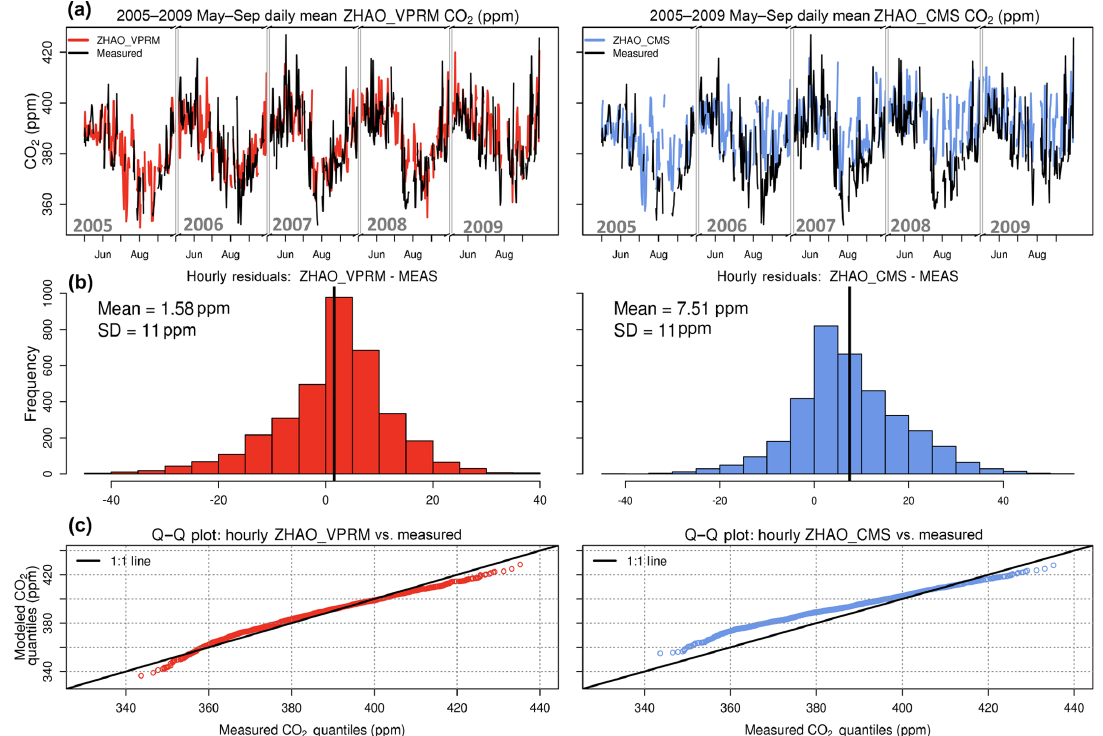
Figure 8. Comparison of modeled and measured CO 2 during May–September 2005–2009, using two different vegetation models. (a) Daily averages, for visual clarity; (b) distribution hourly modeled–measured residuals; (c) comparison of modeled and measured hourly distribu- tions using a Q – Q